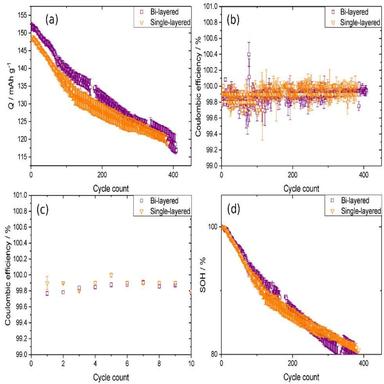
(a) Capacity retention of the FCCs based on NMC cathode and single- (orange) and bi-layered (purple) anodes. (b) Coulombic efficiency during the whole cycle life of the cells and (c) during the first 10 cycles and (d) SOH of the cells with the number of cycles. Error bars indicate standard deviation between the different cells tested.